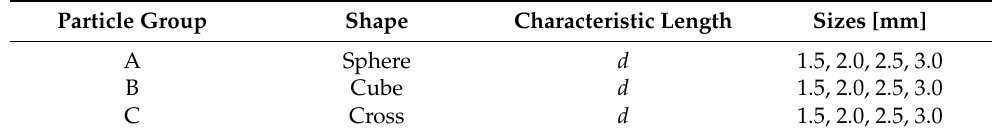
Table 1. Specification of shape and characteristic length of MP